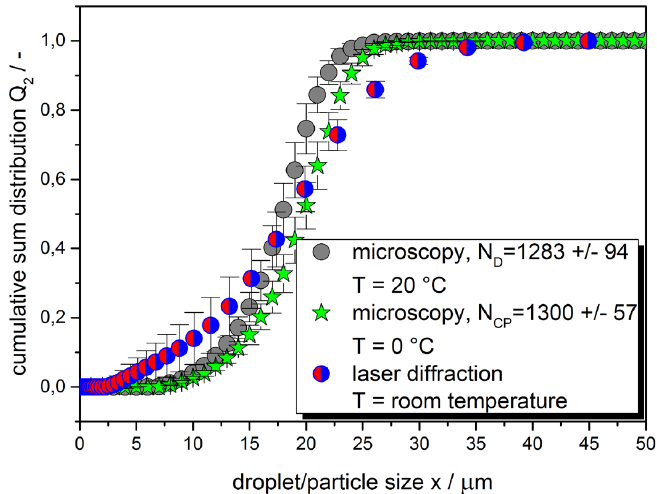
Figure 6. Cumulative area sum distribution Q 2 of 1 wt % hexadecane in Milli-Q water emulsions stabilized with 1 wt % Tween ® 20. Filled circles, one color: DSD measurements with polarizing microscope at 20 °C of liquid droplets. Filled stars, one color: Particles size distribution (PSD) measurements with polarizing microscope at 0 °C of crystallized droplets. Filled circles, bicolor: DSD measurements using laser diffraction and Mie theory at room temperature (above melting point of hexadecane) of liquid droplets.